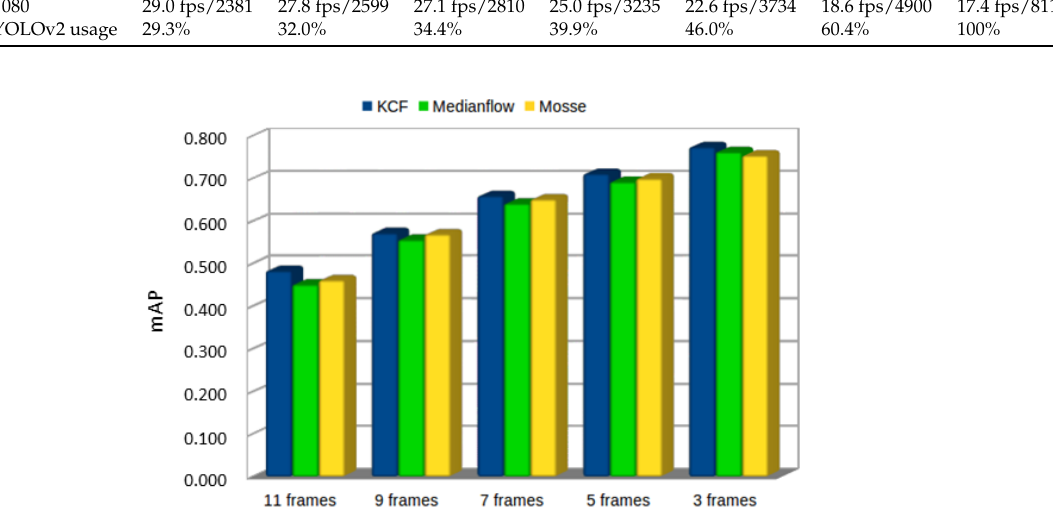
Figure 15. mAP for KCF, Median flow and Mosse tracking algorithms every n